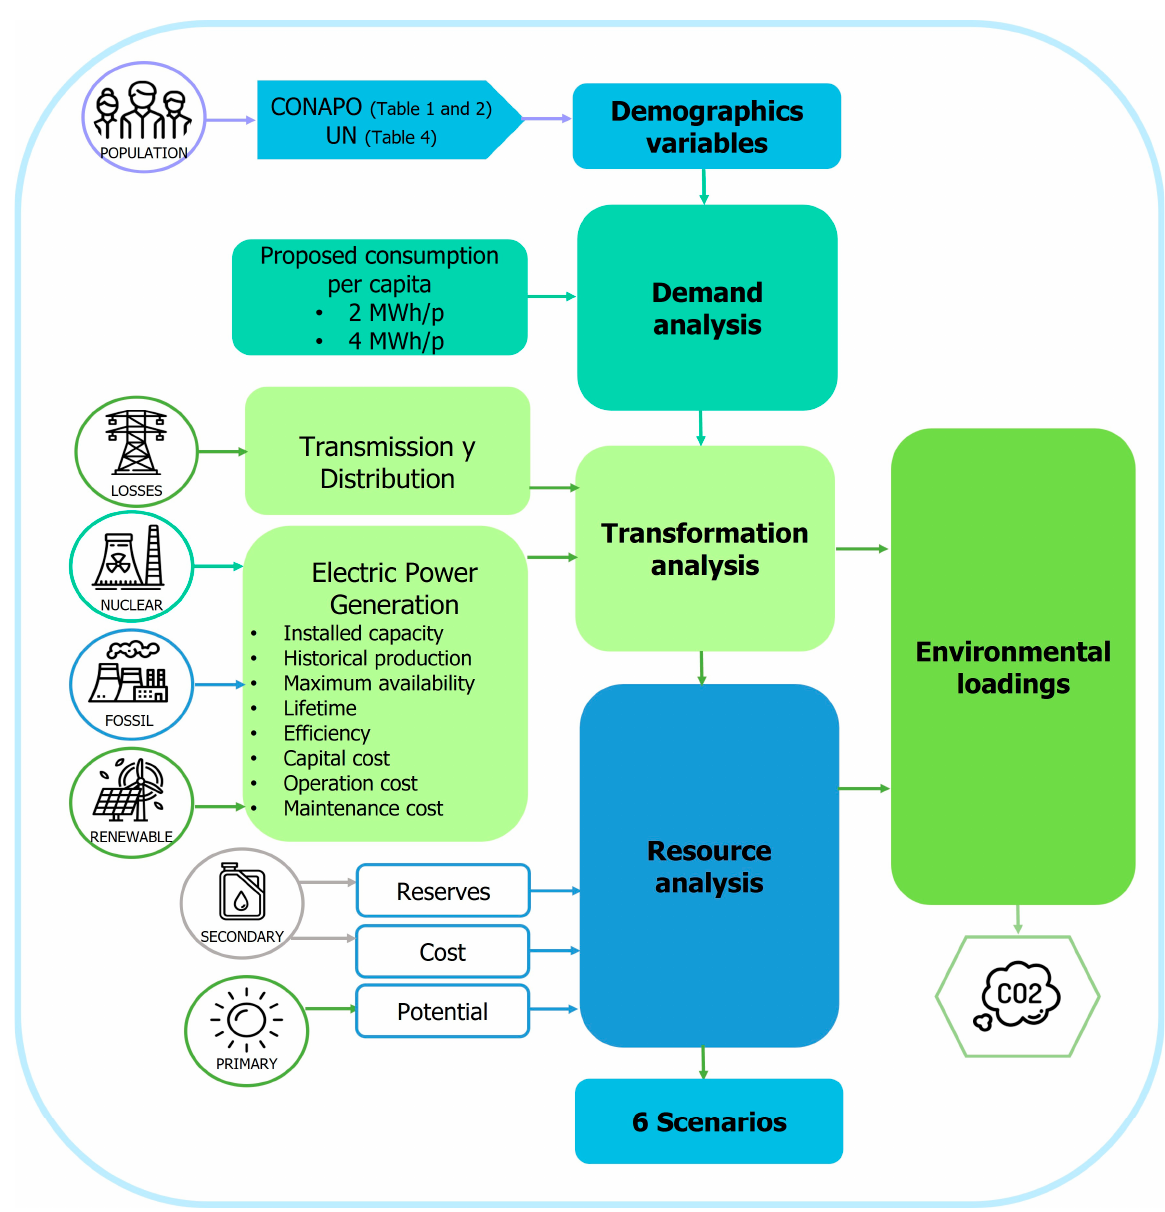
Figure 1. Schematic representation of NES-50. Table 1. Historical population in the middle of the year for Mexico. Source: